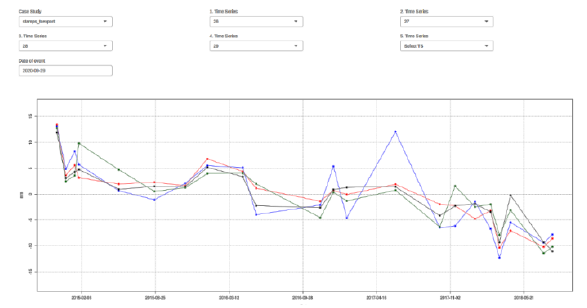
Figure 7 . Relation between the PS obtained in the Pier and comparison over time before its collapse.